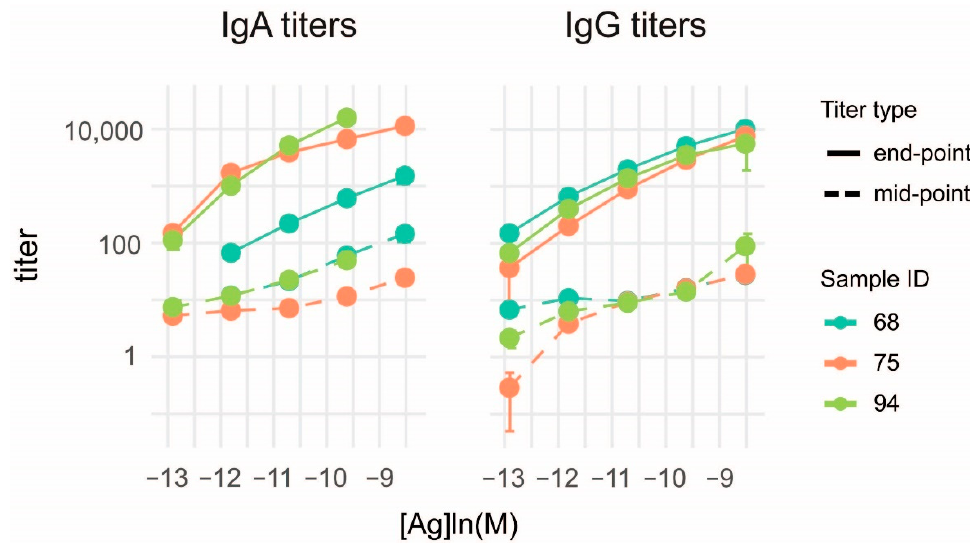
Figure 3. Comparative characterization of serum antibody binding. Using the values of the param- eters obtained by curve fitting, calculated thermodynamic activity coefficient distributions are com- parable not only for ( A ) serum samples but also for ( B ) distinct antibody classes. Results shown in Figure 2 were used for the generation of normalized comparisons. Bar charts ( C ) show mean d and x i values, and 95% confidence intervals as whiskers.